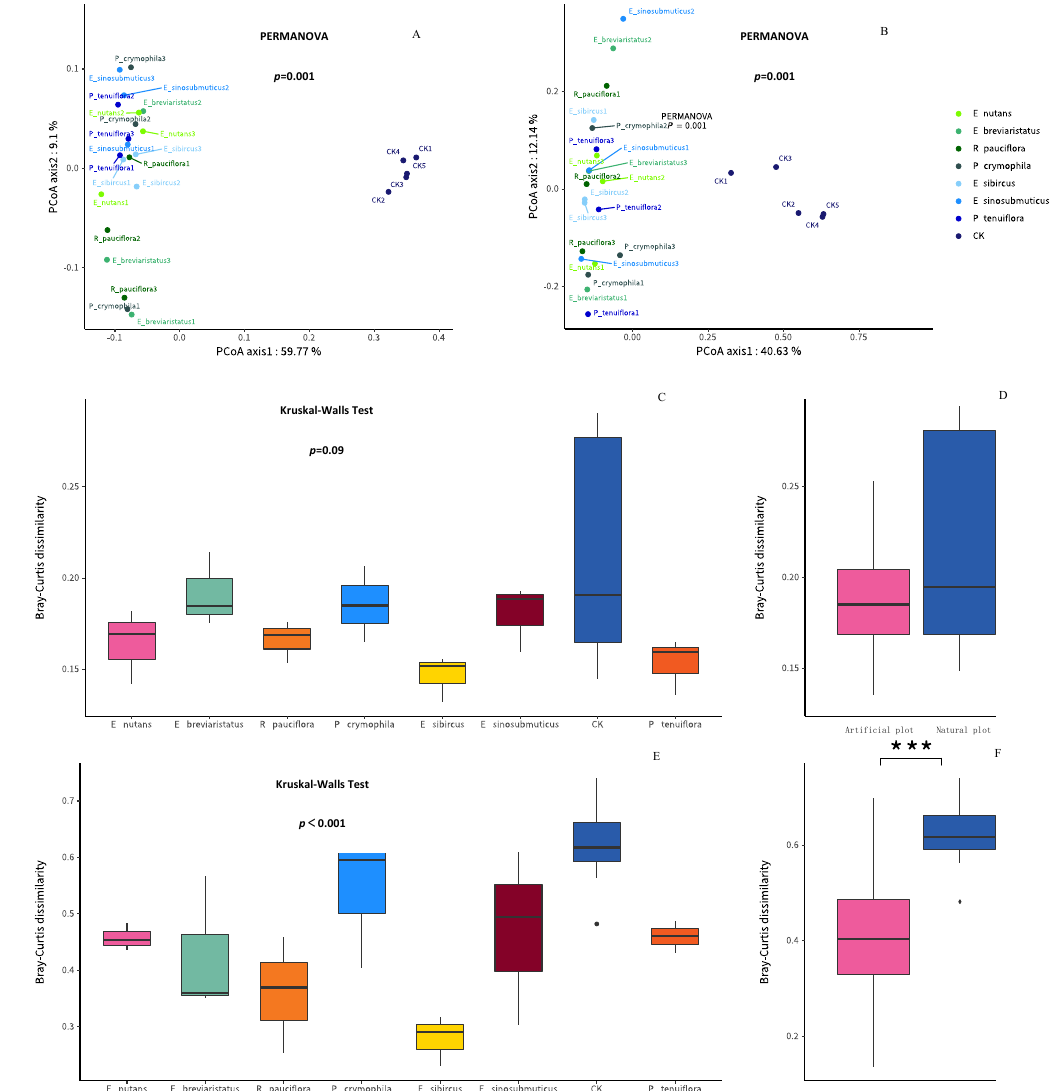
Figure 3. Principal coordinates analysis and within stage dissimilarity of bacteria (A, C, D) and fungal (B, E, F) communities at artificial and natural grassland. E breviaristatus: Elymus breviaristatus . E nutants: Elymus nutans . E sibircus: Elymus sibircus . E sinosubmuticus: Elymus sinosubmuticus . P crymophila: Poa crymophila . P tenuiflora: Puccinellia tenuiflora . R pauciflora: Roegneria pauciflora . *: p ＜ 0.05, **: p ＜ 0.01, *** p ＜ 0.001.